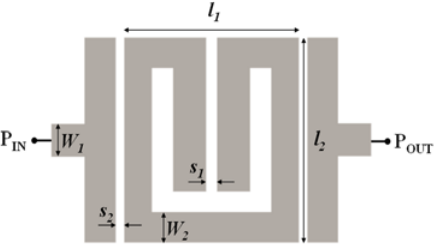
Figure 1. Layout of the sensitive part of the reader. Dimensions (in mm) are: l 1 = 3.16, l 2 = 3.35, S 1 = 0.2, S 2 = 0.2, W 1 = 0.56, and W 2 = 0.5.